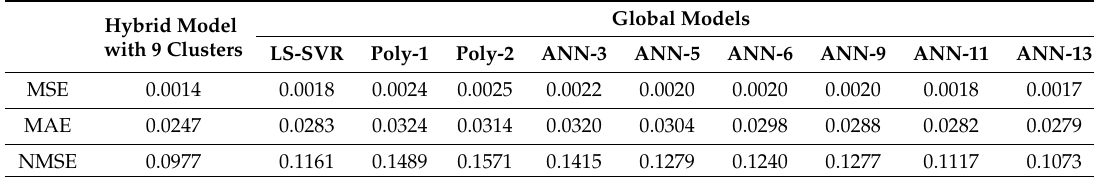
Table 9. Hybrid intelligent approach vs. global models with different regression